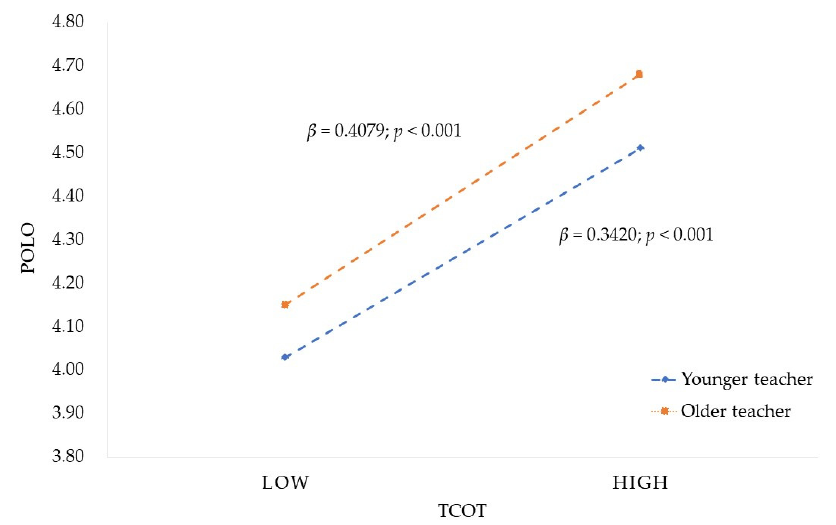
Figure 3. Moderating role of TA in the relationship between TCOT and POLO. (Source: drawn up by the authors).